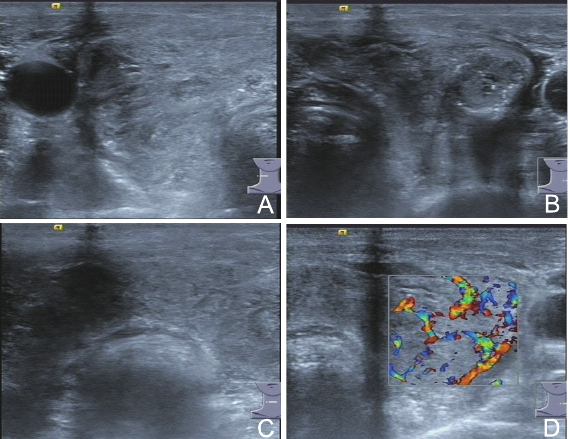
Figure 2 The ultrasound manifestation of the whole thyroid was diffuse swelling after FNAB (A, right; B, left & C, isthmus). CDFI also showed slightly increased vascularity in some parts of these crack areas (D).